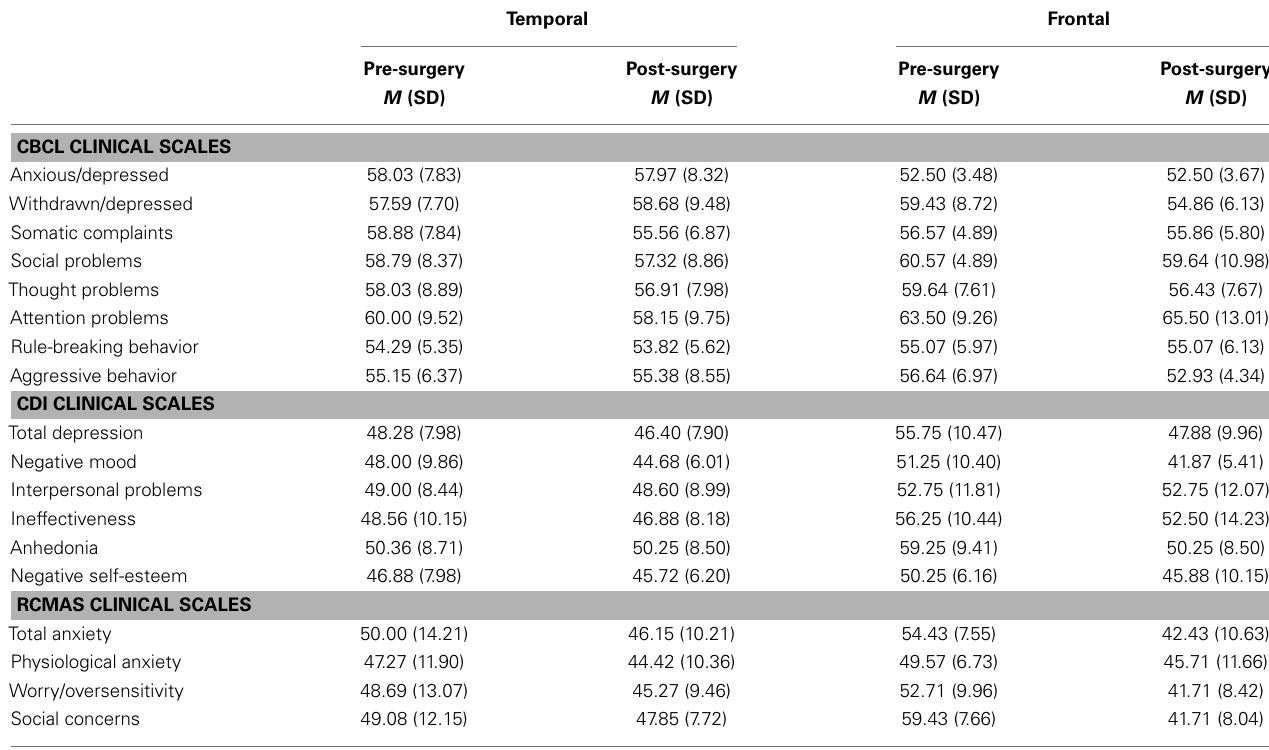
Table 2 | Mean scores on mood, anxiety, and behavior measures for patients who underwent left-sided surgeries